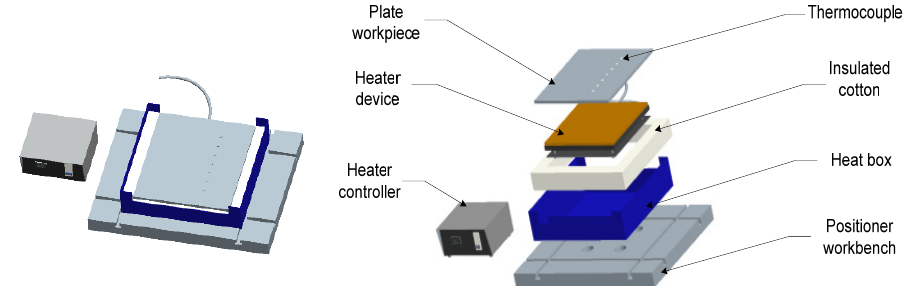
Figure 2. Exploded view of heating system for thermal machining.